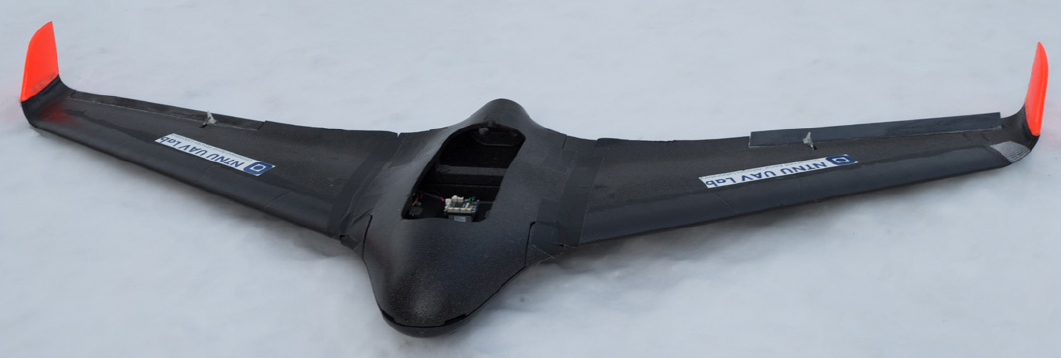
Figure 1. The implemented sensor timing board (SenTiBoard) in various configurations. In 1a the full-sized SenTiBoard with legs for attaching to an ODroid XU4 is shown; in 1b the SenTiStack is shown in a small configuration, without an onboard computer; and in 1c the configuration in 1b is shown mounted in a fixed wing UAV.